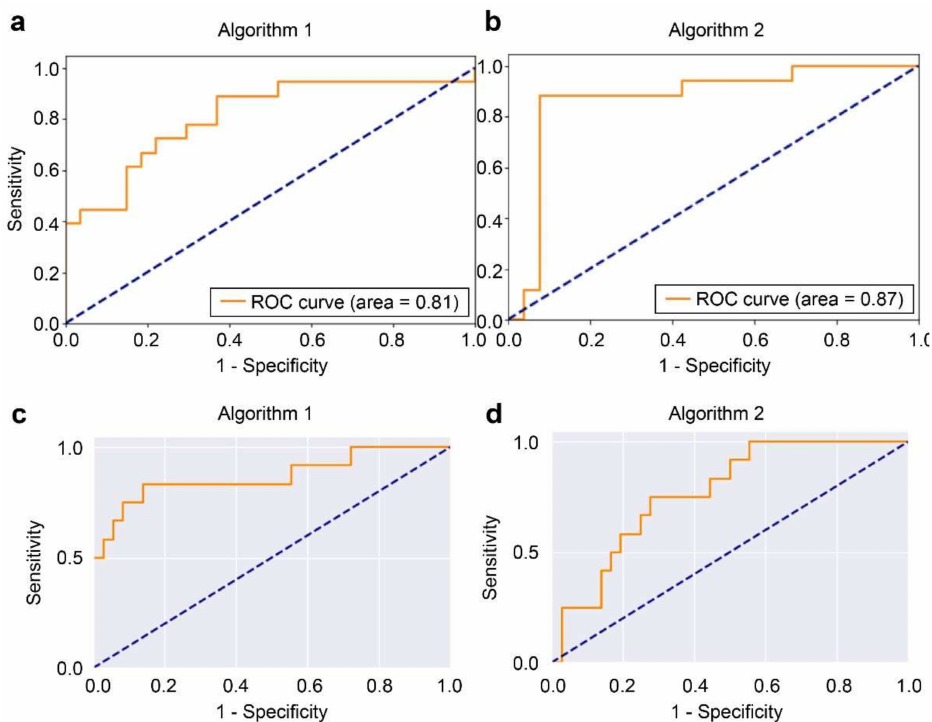
Figure 3. The ROC curves of algorithms ( a ) 1 and ( b ) 2 for the internal dataset. The ROC curves of algorithms ( c ) 1 and ( d ) 2 for the external dataset. ROC, receiver operating characteristic.